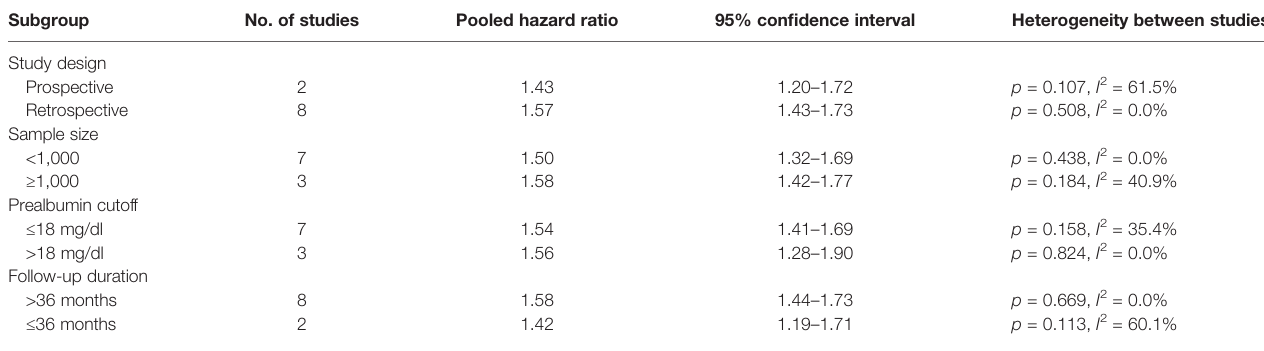
TABLE 2 | Results of subgroup analysis on overall survival.